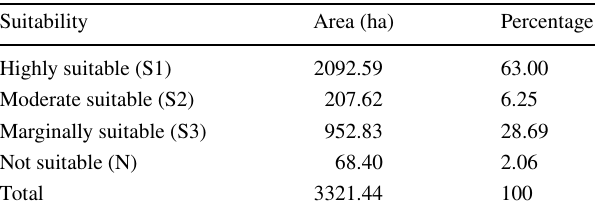
Table 9 The distribution of land suitability classes for agricultural purpose in the study